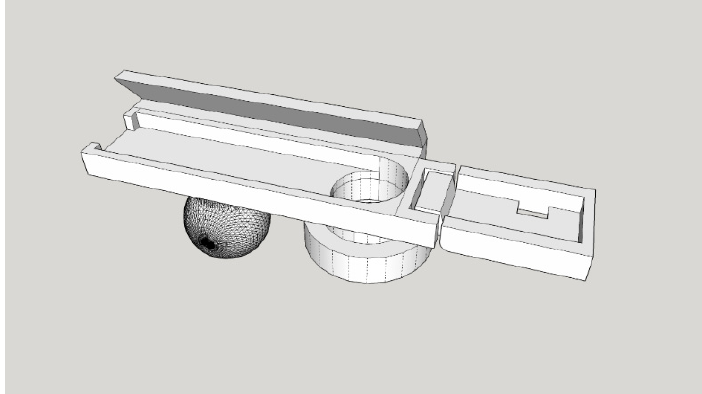
Figure 3. Three-dimensional diagram of the camera module housing.